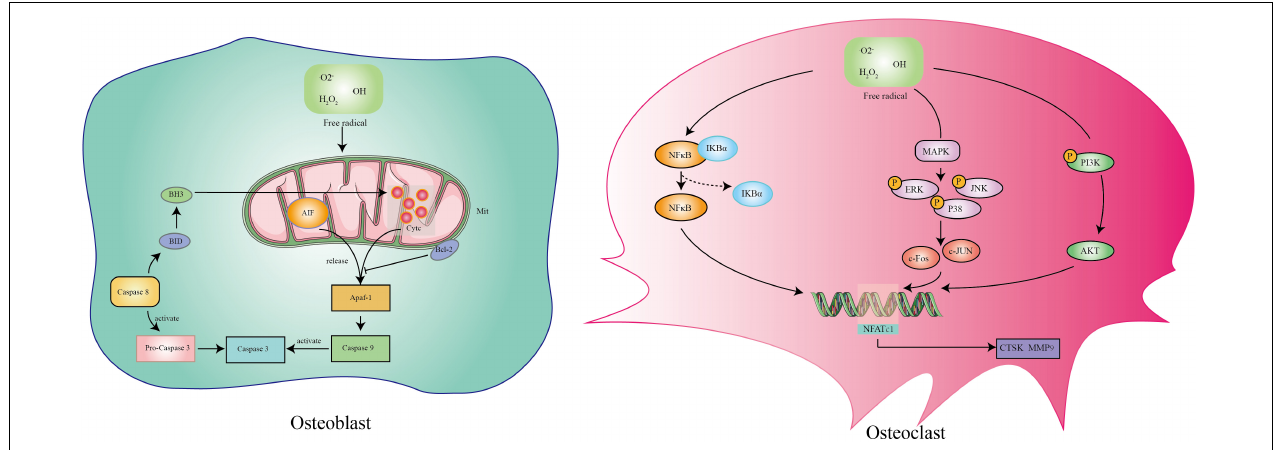
FIGURE 2 | The mechanism of reactive oxygen species on osteoblasts and